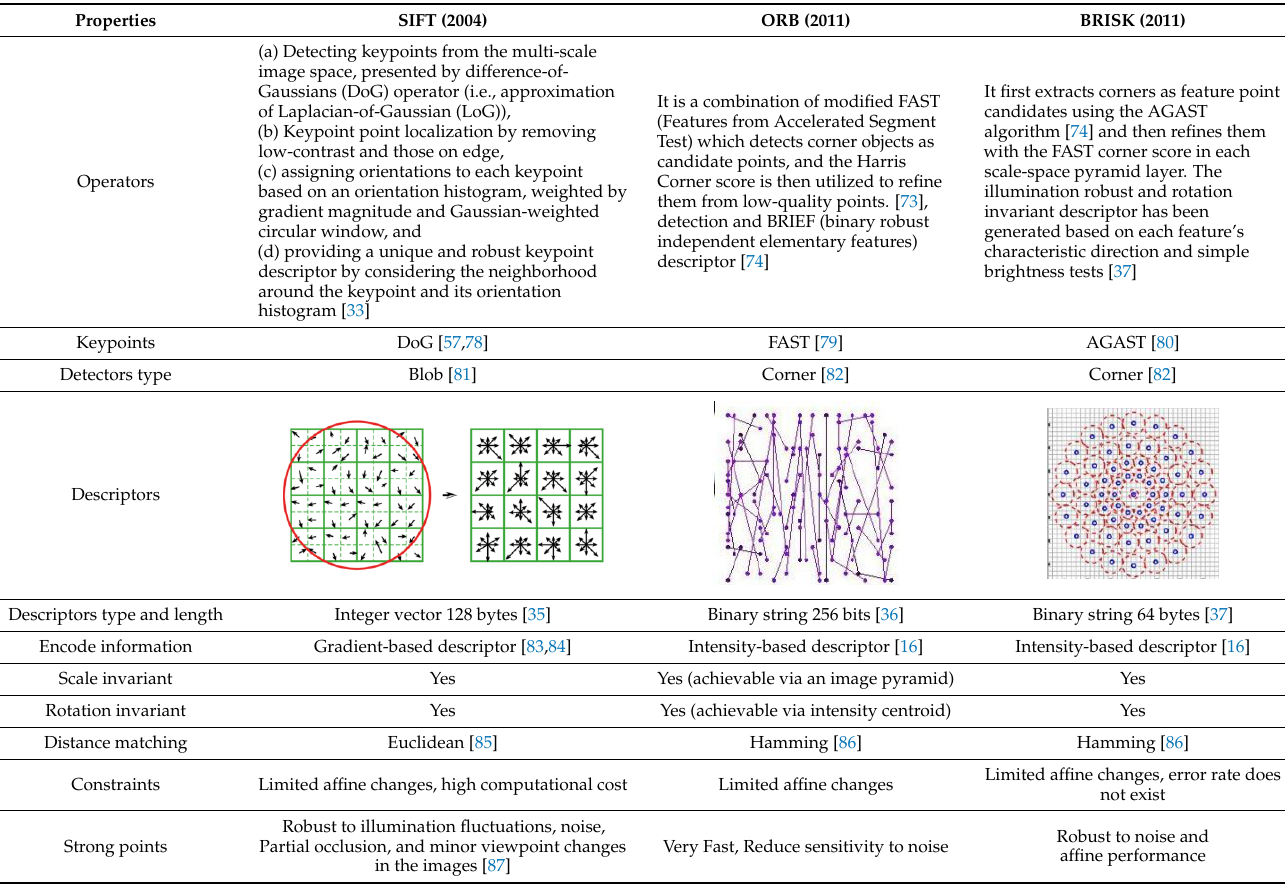
Table 1. Illustration of a brief comparison of SIFT, ORB, and BRISK algorithms.